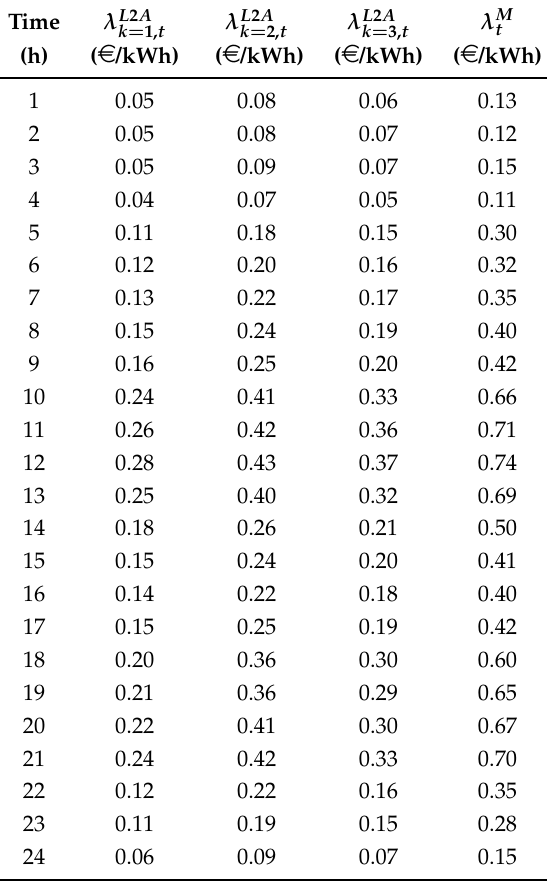
Table 1. Prices of energy traded between consumers and aggregators adapted with permission from [19].